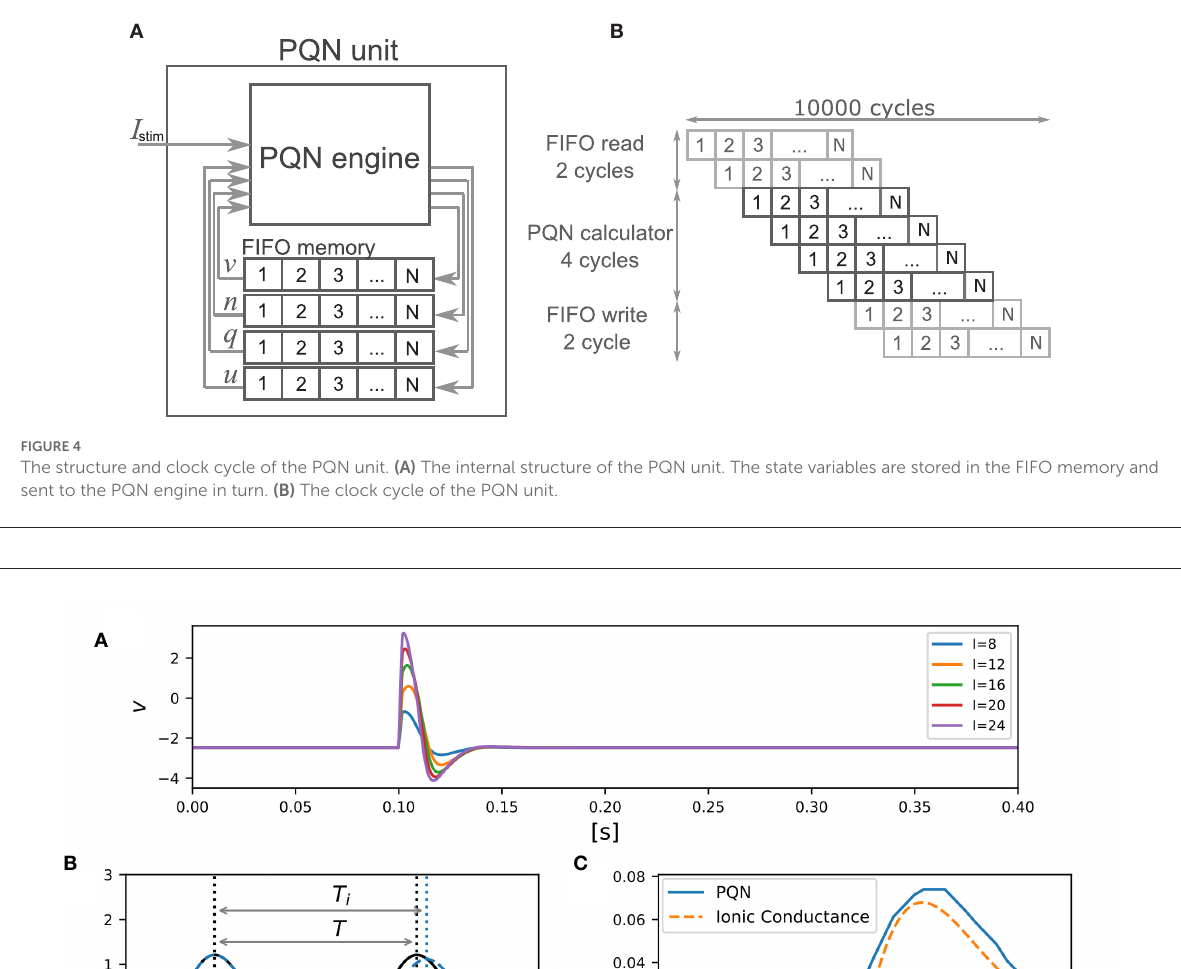
in the IB mode exhibit burst firing immediately after step